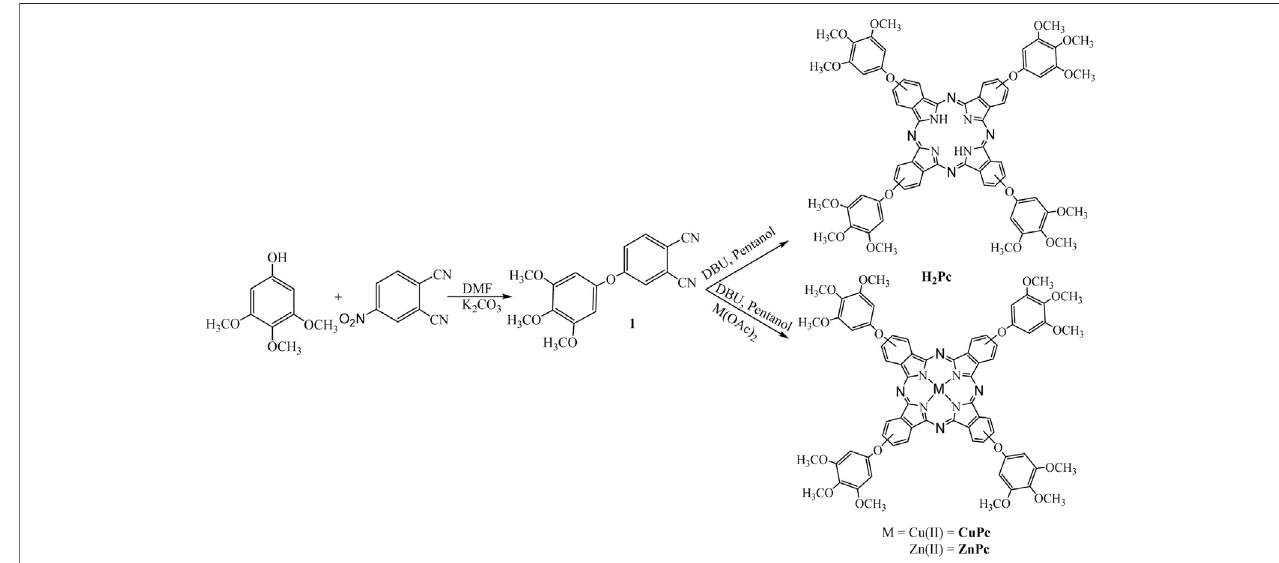
FIGURE 1 | Synthetic scheme of